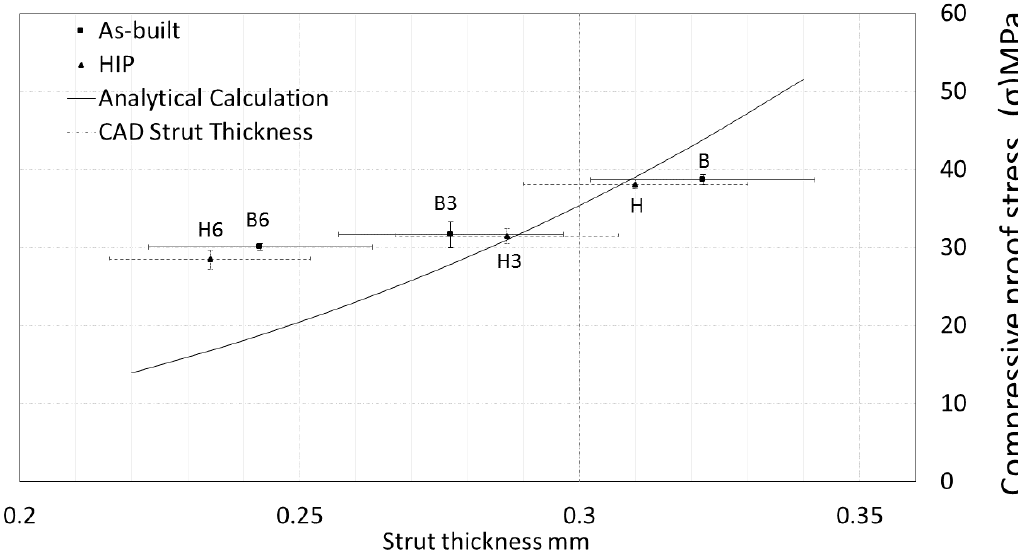
Figure 7. The e ff ect of posttreatment on strut thickness and compressive proof stress of the porous